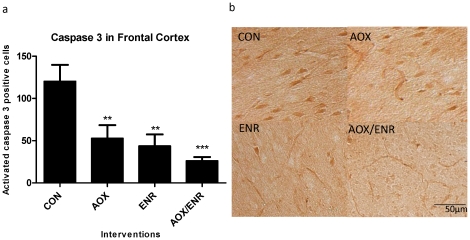
Immunohistochemical staining for caspase 3 in aged canine brains.
a) Caspase 3 immunohistochemical staining in frontal cortices of aged dogs treated with AOX and/or ENR interventions showed significant reduction in expression of active caspase 3. **p<0.01,***p<0.001. CON: control environment/control diet; AOX: control environment/antioxidant diet; ENR: behavioral enrichment/control diet; AOX/ENR: behavioral enrichment/antioxidant diet b) representative images of caspase 3 staining in frontal cortices.